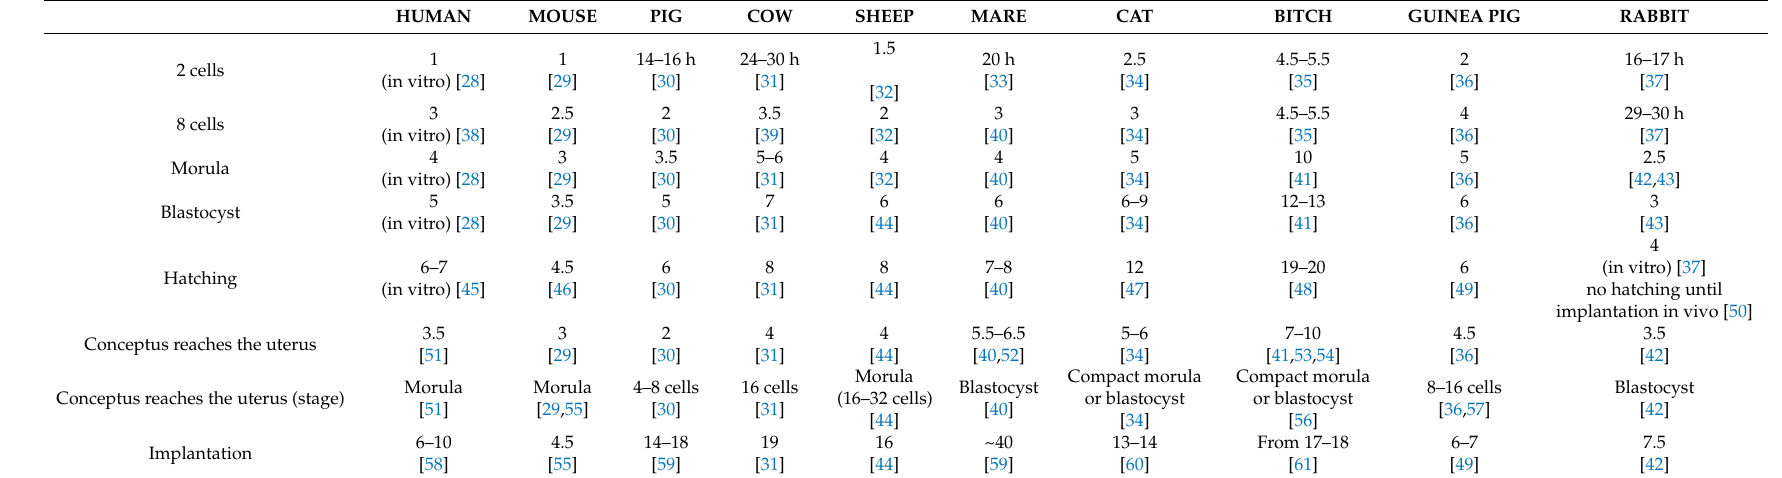
Table 1. Chronology of embryo development in di ff erent